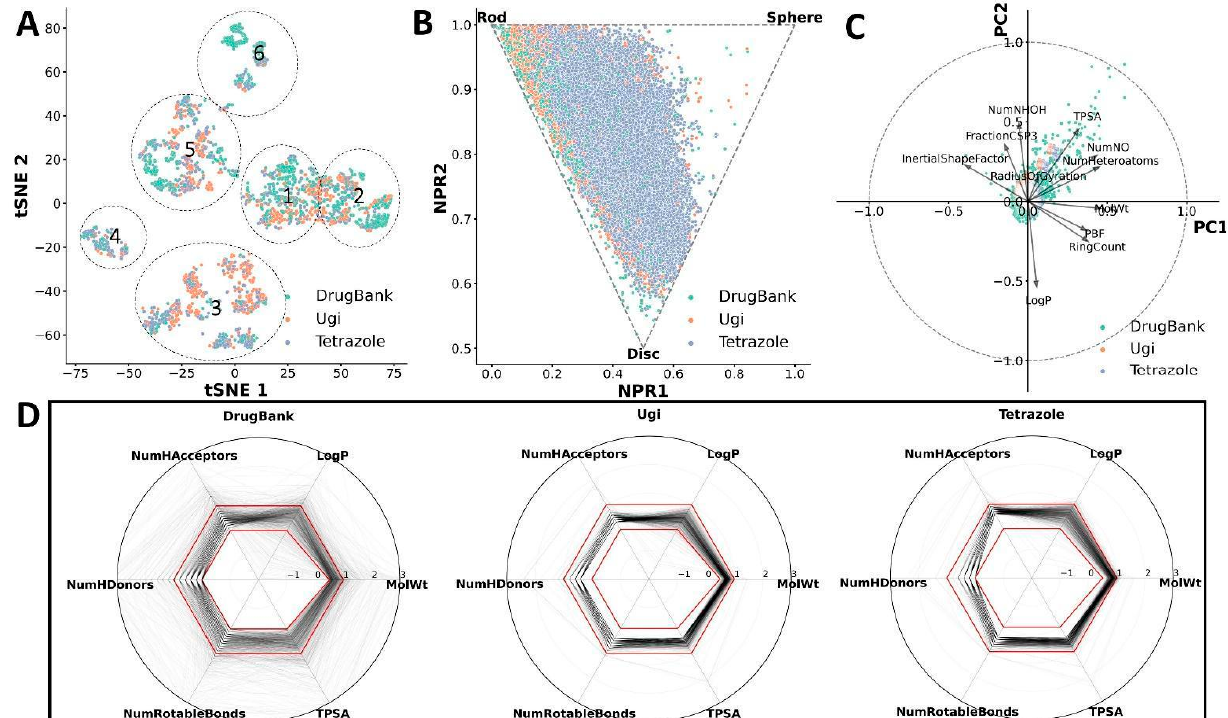
Figure 2. Characteristics of the generated libraries. ( A ) t-distributed stochastic neighbor embedding (tSNE) chart of structural diversity analysis for the compounds generated by Ugi three-component reaction (Ugi) or Ugi four-component tetrazole synthesis (Tetrazole). For comparison, a database containing FDA-approved molecules was included (DrugBank). ( B ) Normalized principal moments ratio (NPR) analysis. ( C ) Principal components analysis (PCA) for molecular and physicochemical descriptors. ( D ) Lipinski’s rule of five (Ro5) analysis, which included molecular weight (MolWt), logarithmic partition coefficient (LogP), number of hydrogen bond donors (NumHDonors) and acceptors (NumHAcceptors), and the topological polar surface area (TPSA). A gray line represents each compound, and the density indicates the frequency of compounds.